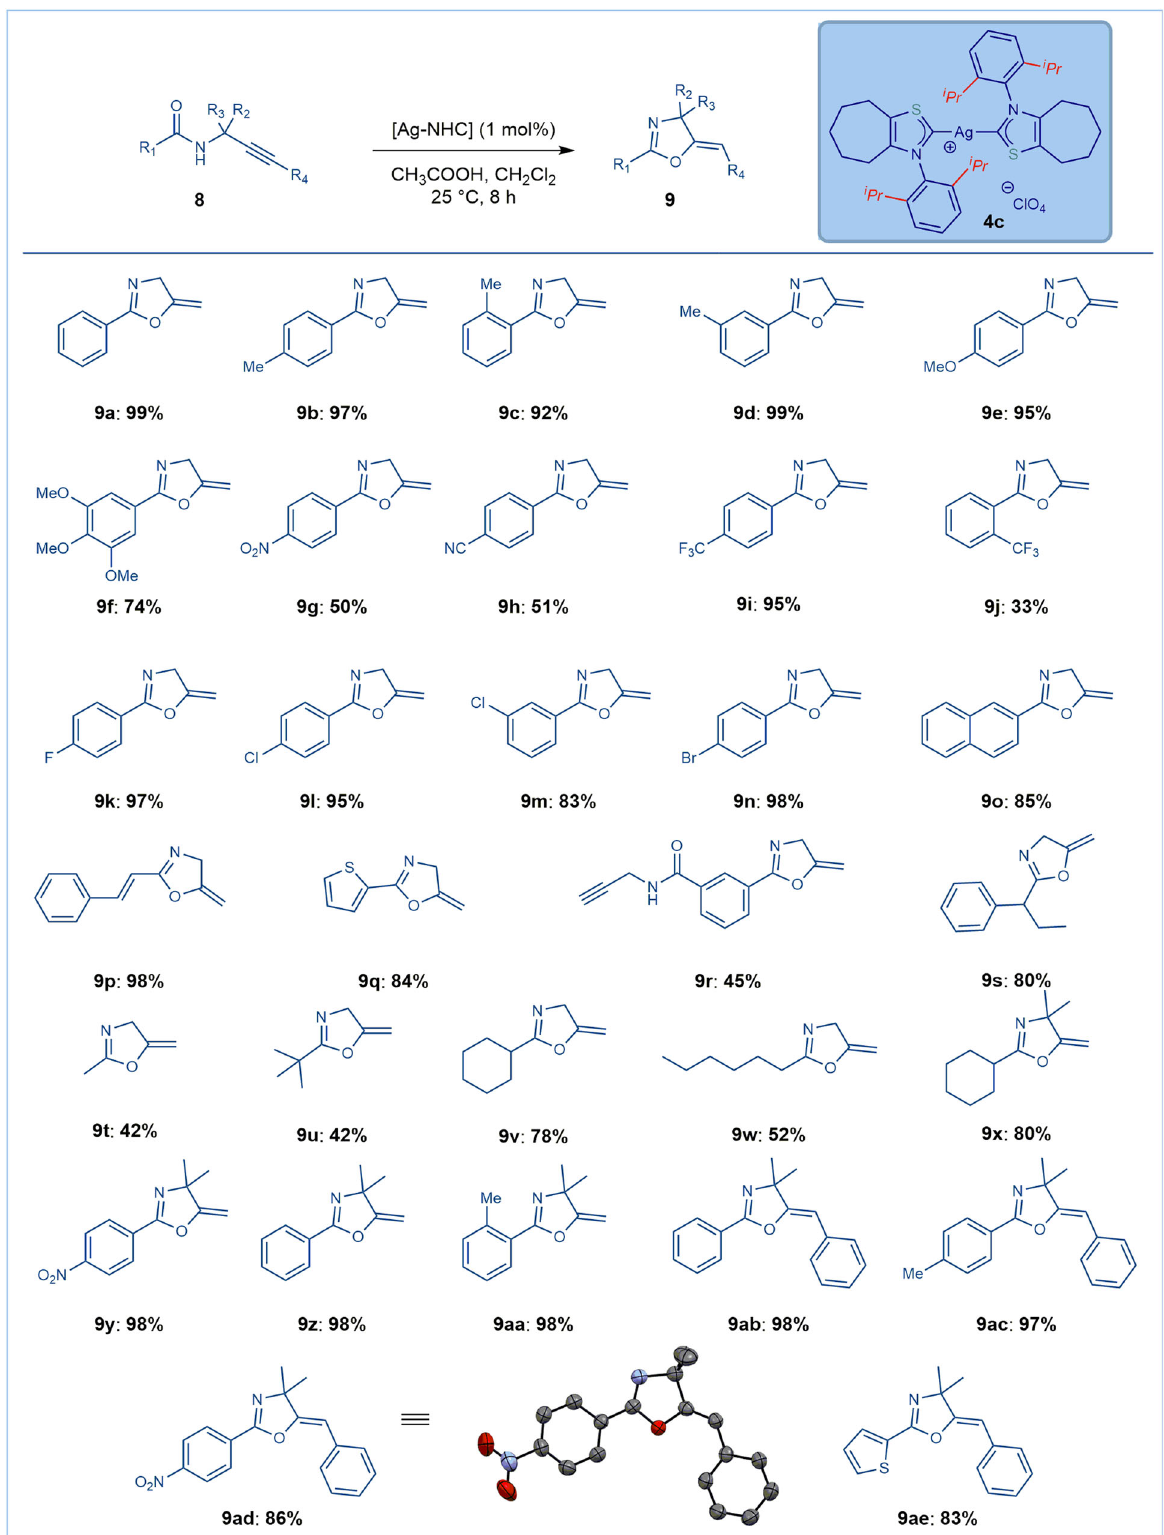
Fig. 7 Scope of Ag – NHC-catalyzed cyclization of N -propargylic amides. Conditions: amide (1.0 equiv), catalyst 4c ([Ag], 1 mol%), CH 3 CO 2 H (1.0 equiv), CH 2 Cl 2 (1.0 M), 25 °C, 8 h. See Supplementary Method 9 for details, 9ad : CCDC: